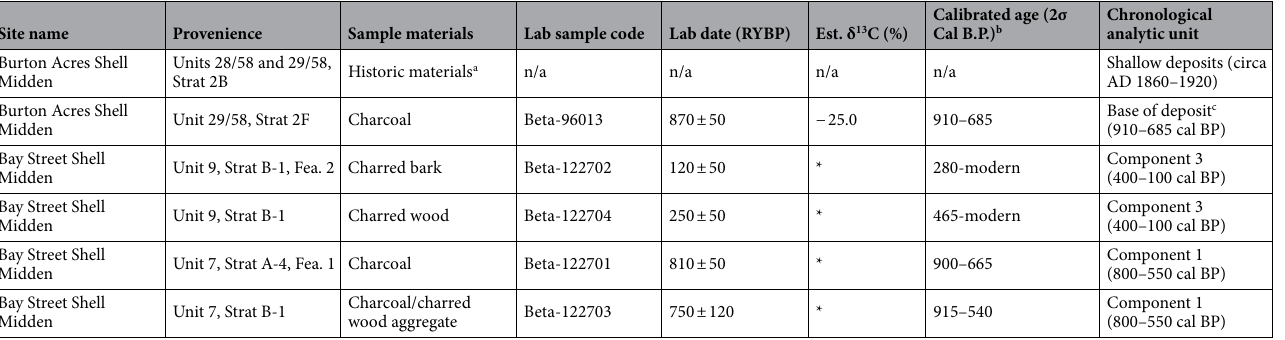
Table 1. The relative age of each archaeological sample collection. *Not provided in the original report 51 . a Historic material limited to upper strata (1, 2A-2C); temporally diagnostic items include a Seated Liberty dime, lead shot, and a button. b Calibrated with OxCal 4.4 with IntCal 20 83,84 . c Two other radiocarbon dates were obtained from Strat 2F. One was one on unburned wood that required extended counting and resulted in a lab date of 120 ± 80 RYBP and was interpreted as intrusive into the deposit from more recent activity 53 . The second was on a fragment of marine shell resulting in a lab date of 1000 ± 60 RYBP, and once corrected for marine reservoir effects yielded a calibrated probabilistic age estimate centered on about 800 cal BP 85